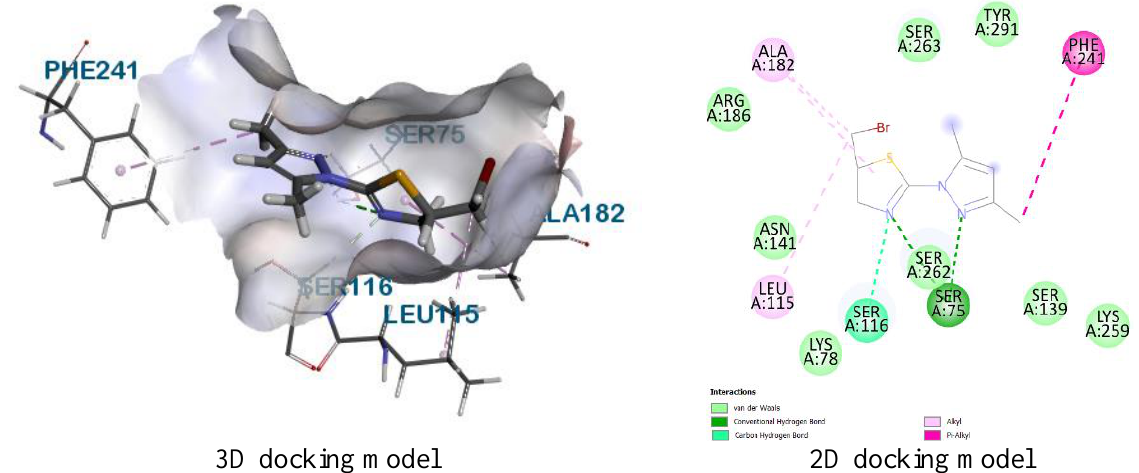
Molecules 2022 , 27 , x FOR PEER REVIEW Figure 5. Complex between 8 and Penicillin binding protein 4 S. aureus “Homo sapiens” (3HUN). Derivative 11 showed a higher binding energy of -6.6 kcal/mol with Penicillin bind- ing protein 4 (PBP4) E. coli “Homo sapiens” due to one carbon -hydrogen bond of the car- bon atom (C-4) of the piperidine core of cytisine (Figure 6).